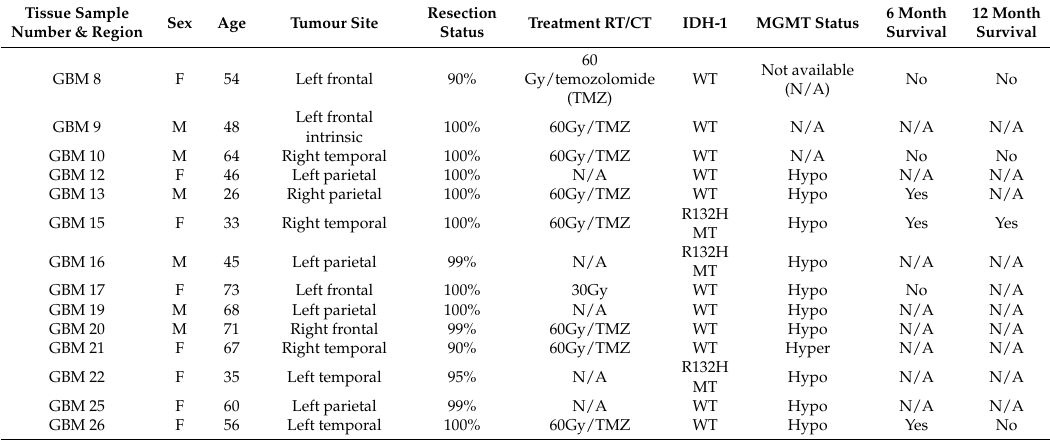
Table 1. Clinical data for GBM patients. All 14 GBMs presented as primary tumour cases. WT, wild- type; MT, mutant. Tissue Sample Number & Region